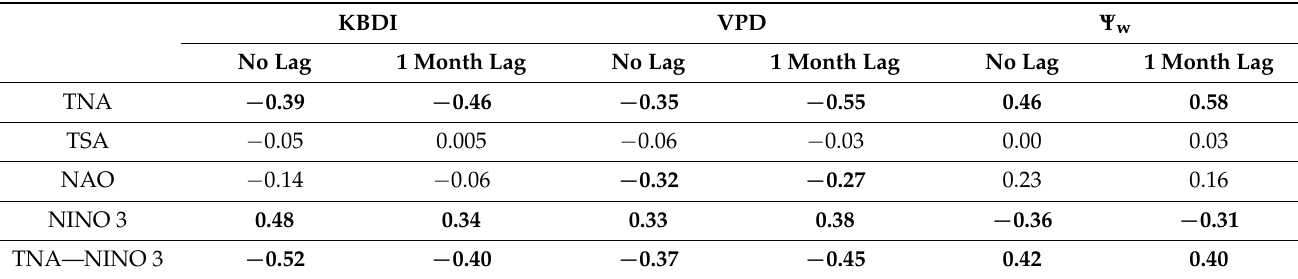
Table 6. Correlations between bushfire potential indices (KBDI, VPD and Ψ w ) for south-central Ja- maica and indices representing large-scale atmospheric and oceanic patterns. Correlations calculated for monthly timeseries over 2013–2017 with zero and 1-month